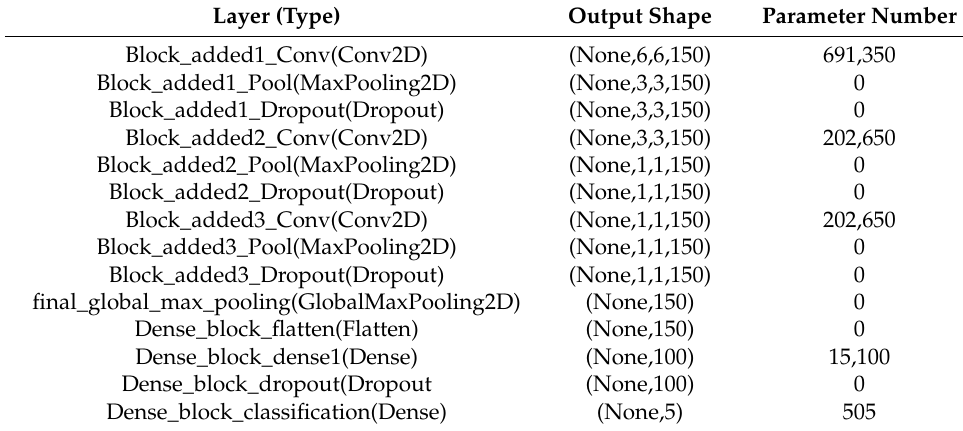
Table 3. Architecture of the CNN added to the base model with the shapes and numbers of